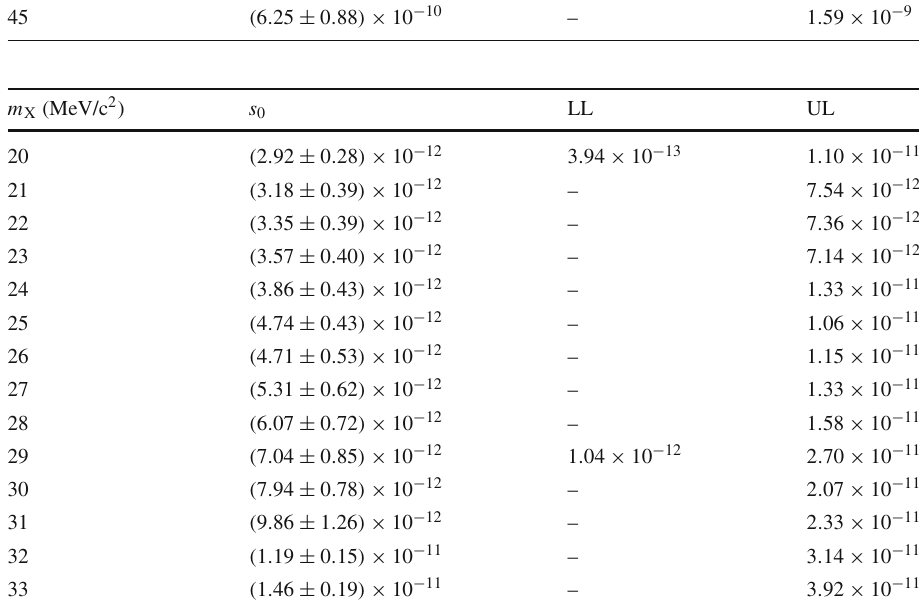
Table 4 Results for τ X = 20